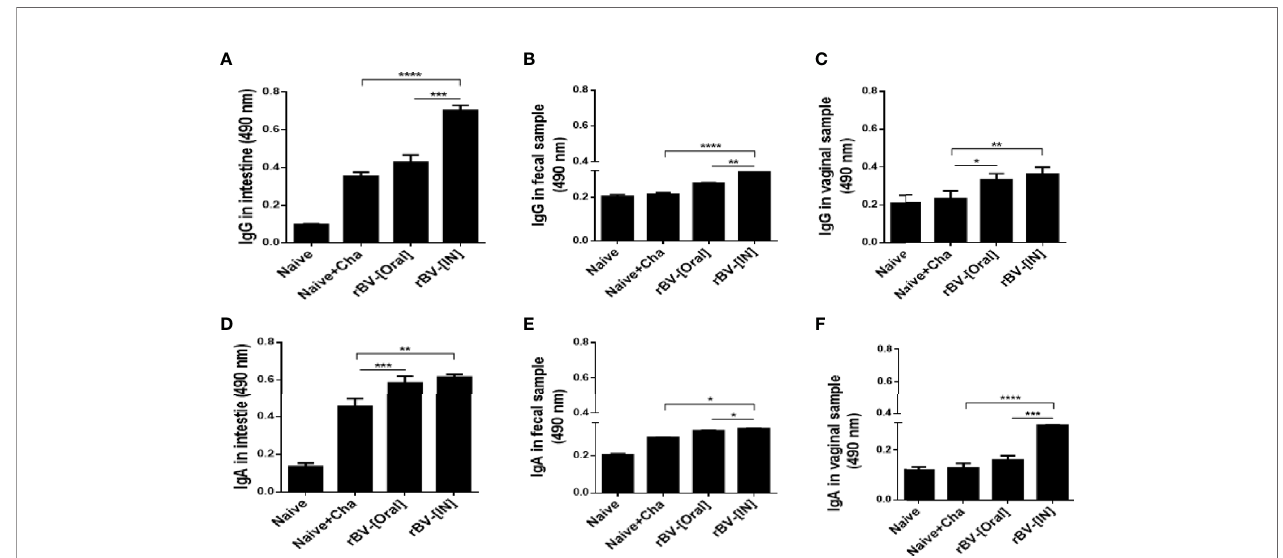
FIGURE 2 | Measurement of enhanced mucosal immune response. T. gondii -speci fi c mucosal IgG and IgA responses in the intestines (A, D) , feces (B, E) , and vaginal samples (C, F) were observed using ELISA. Data are presented as mean ± SD and asterisks indicate statistical differences between groups (* P < 0.05,